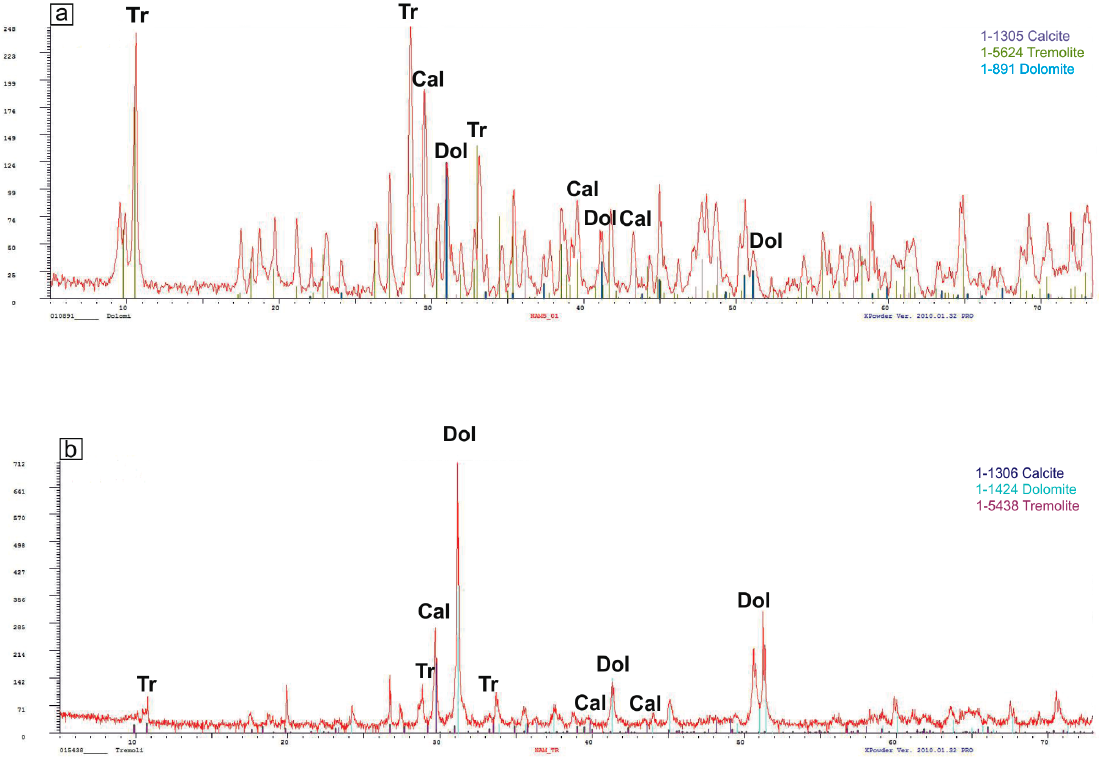
Figure 4. X-ray diffractograms on representative portions of the Karibib white marbles, showing calcite, tremolite, and dolomite as constituting mineral phases. The peak color of each mineral is indicated in the legend. ( a ) main vein; ( b ) massive part.